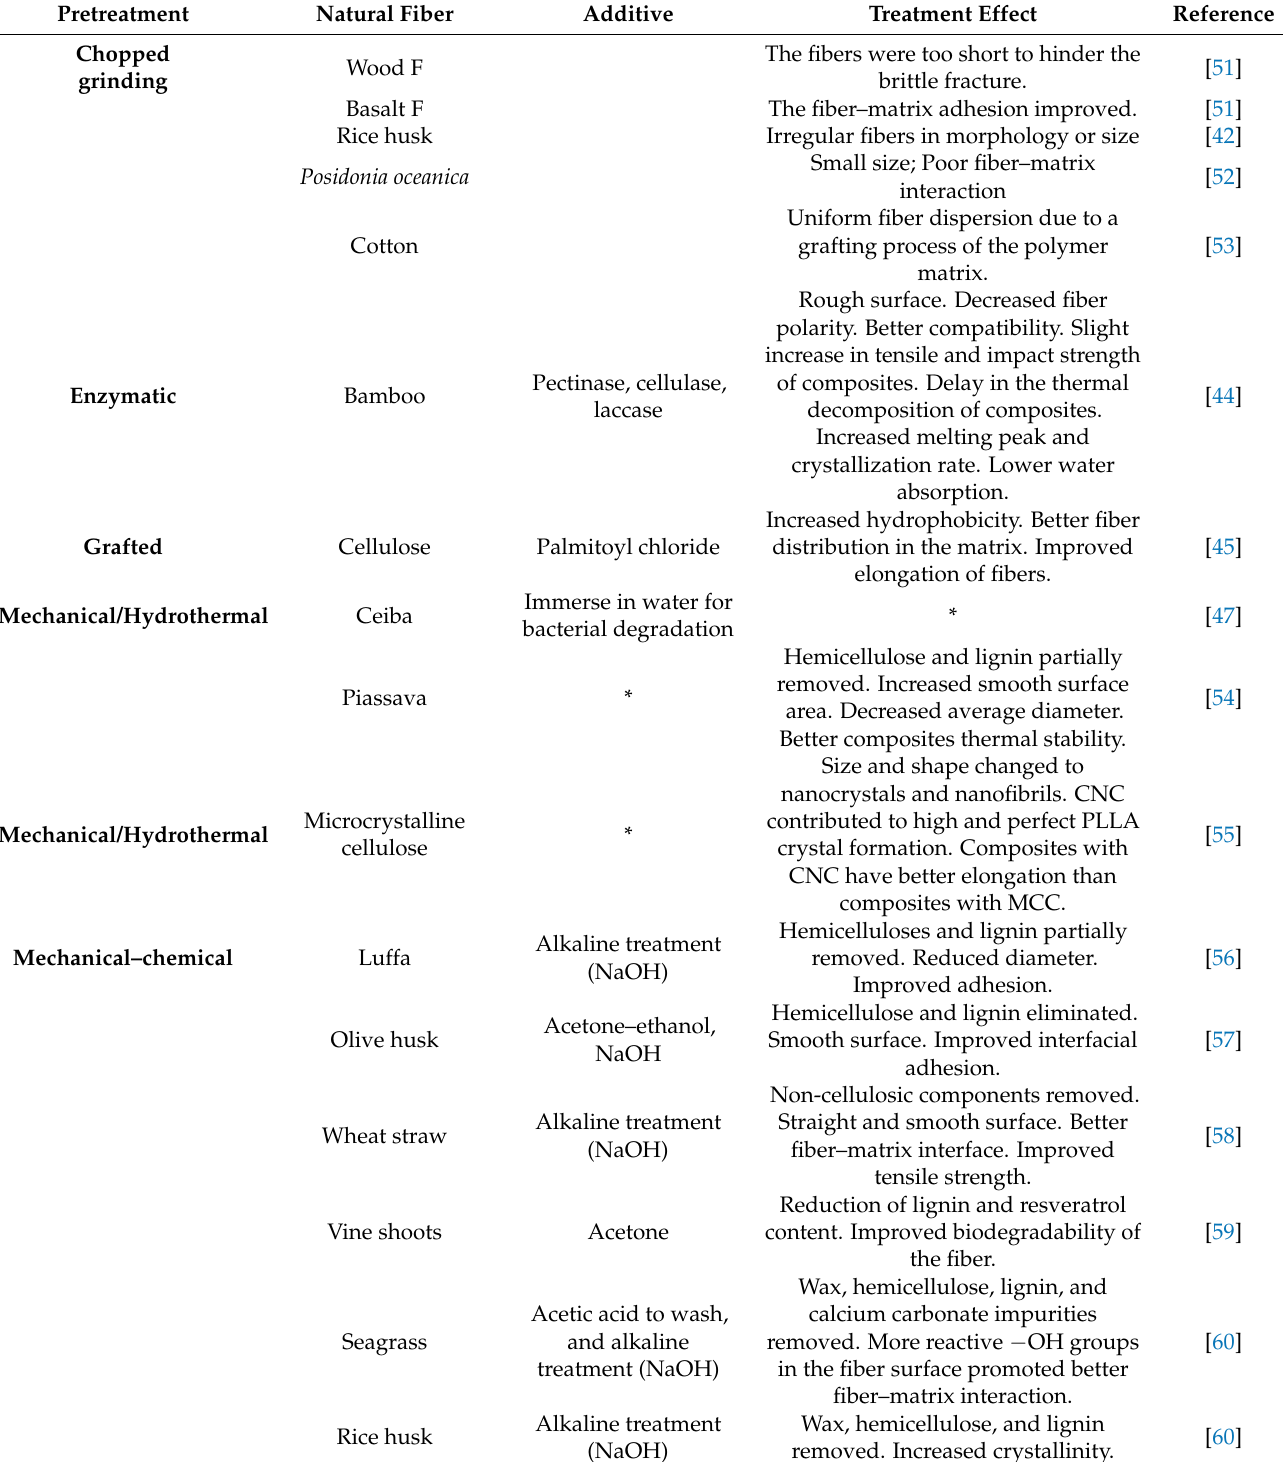
Table 1. Examples of fiber pretreatments used for biodegradable composite